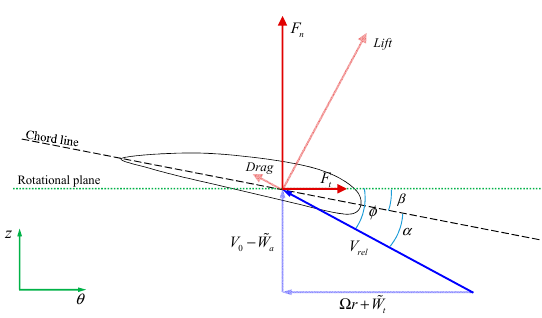
Figure 2. Illustration of the velocity and the aerodynamic force for a blade cross-section.